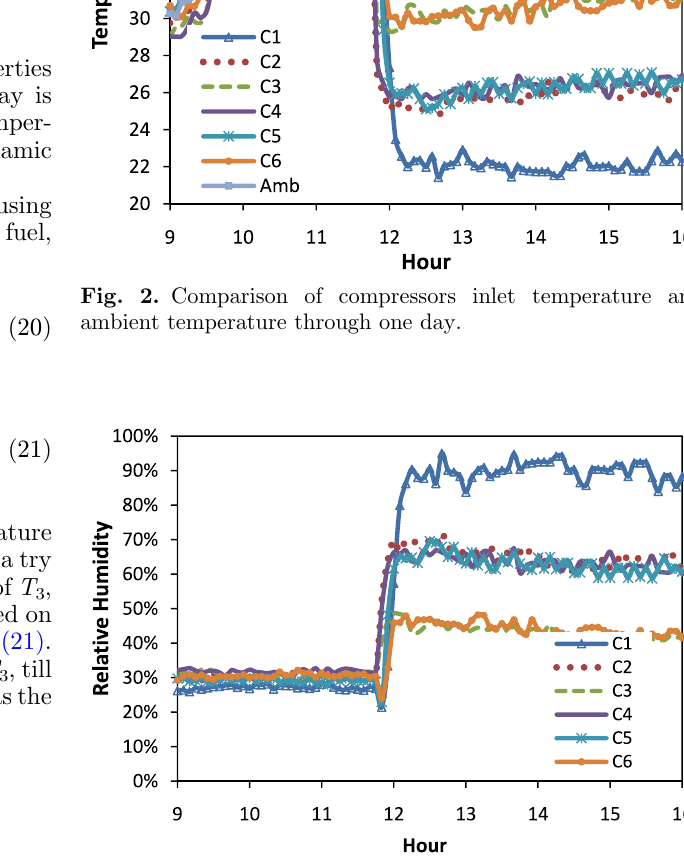
Fig. 3. Relative humidity of inlet air to compressors in one